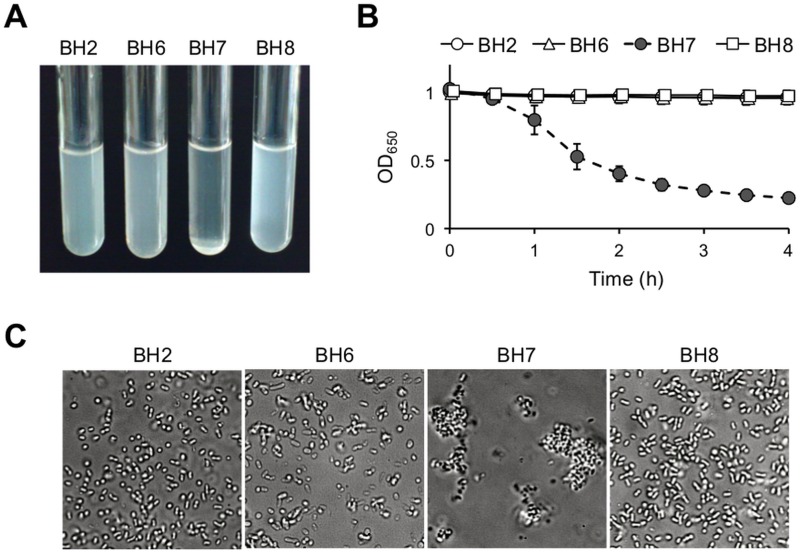
Autoagglutination of Bordetella holmesii isolate BH7.(A) The clinical isolates BH2, BH6, BH7, and BH8 were suspended in casamino acid solution and incubated for 4 h at 36°C under static conditions. (B) Time course analysis of the turbidity (OD650) of the bacterial suspensions. Data are presented as means ± standard deviations of results obtained from 3 separate experiments performed in triplicate. (C) Microscopic analysis of the morphology of the bacterial suspensions. The suspensions were incubated for 4 h at 36°C on glass slides, and observed by phase-contrast microscopy (objective magnification, 100×).